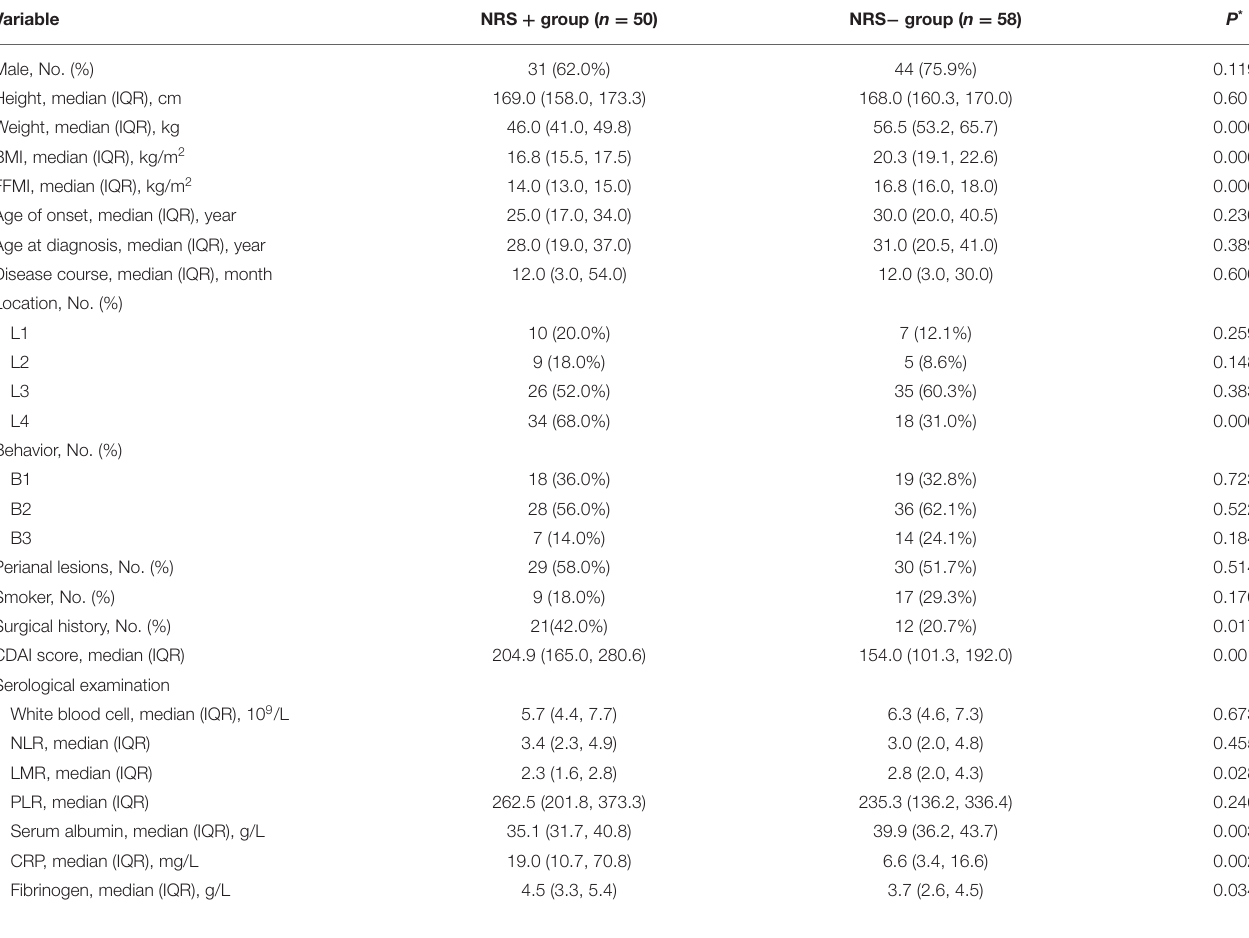
TABLE 2 | Comparison of patients according to the presence of malnutrition risk by NRS